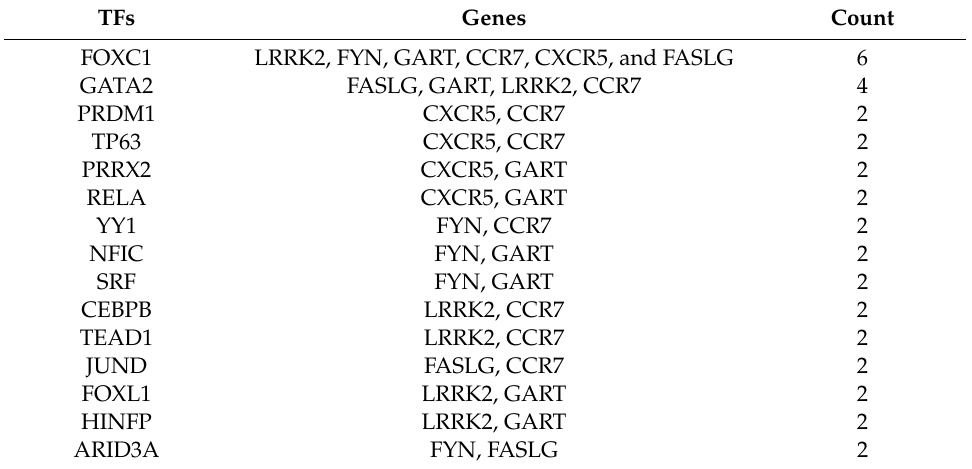
Figure 7. The hub gene-TF regulatory network. Red circle means the hub gene and blue square means the transcription factor. Table 1. The potential TFs of hub